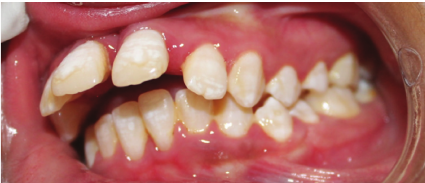
Figure 6: Intraoral picture showing proclination of upper anteriors.